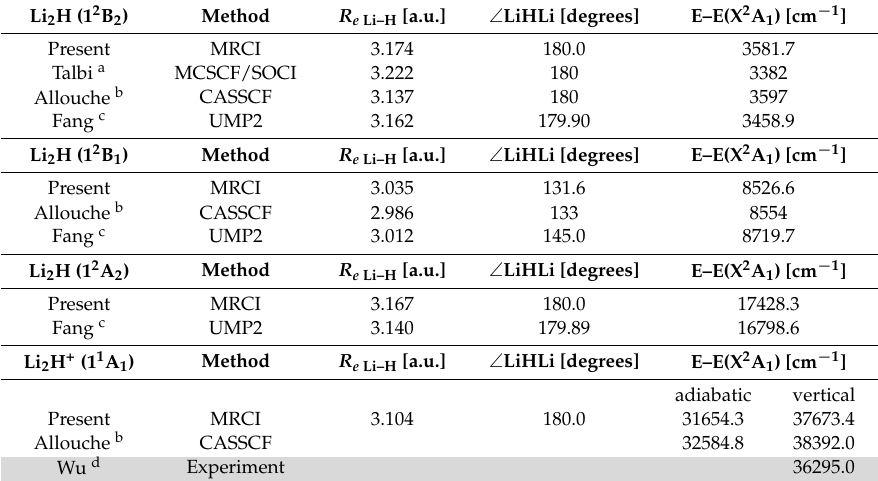
Table 2. Equilibrium geometries and excitation energies of the low-lying excited states of Li 2 H and of Li 2 H + with respect to the X 2 A 1 ground